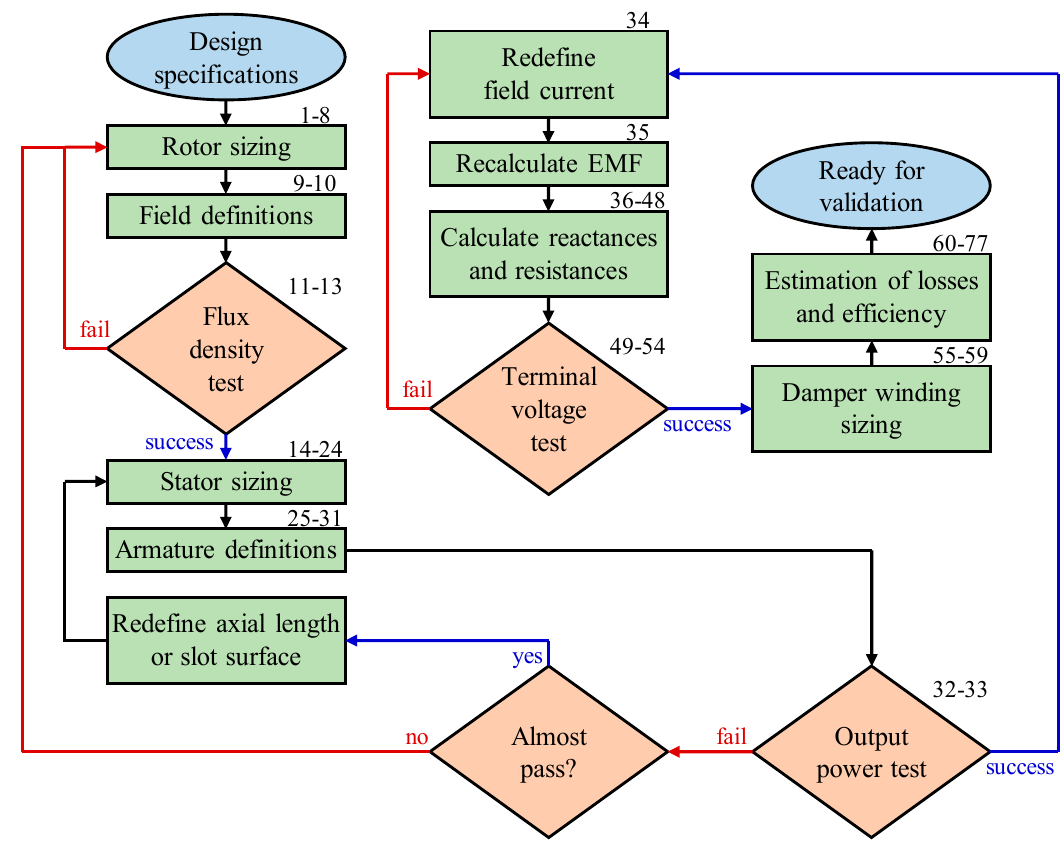
Figure 4. General flowchart of the proposed design methodology. The numbers alongside each block correspond to equation numbers of Section 2.3.